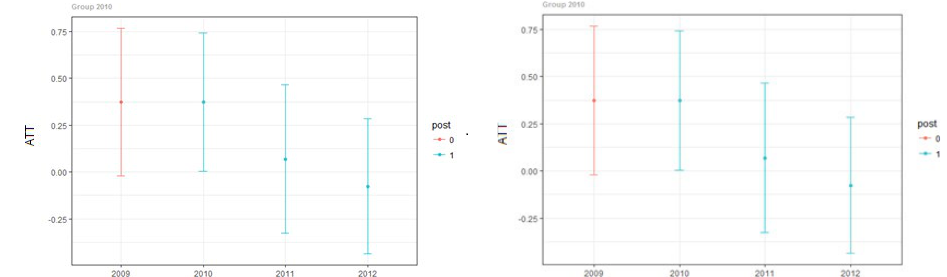
Figure 5. Group-time ATTs estimates (basic mod- el) – Riviera Ligure PDO sample.